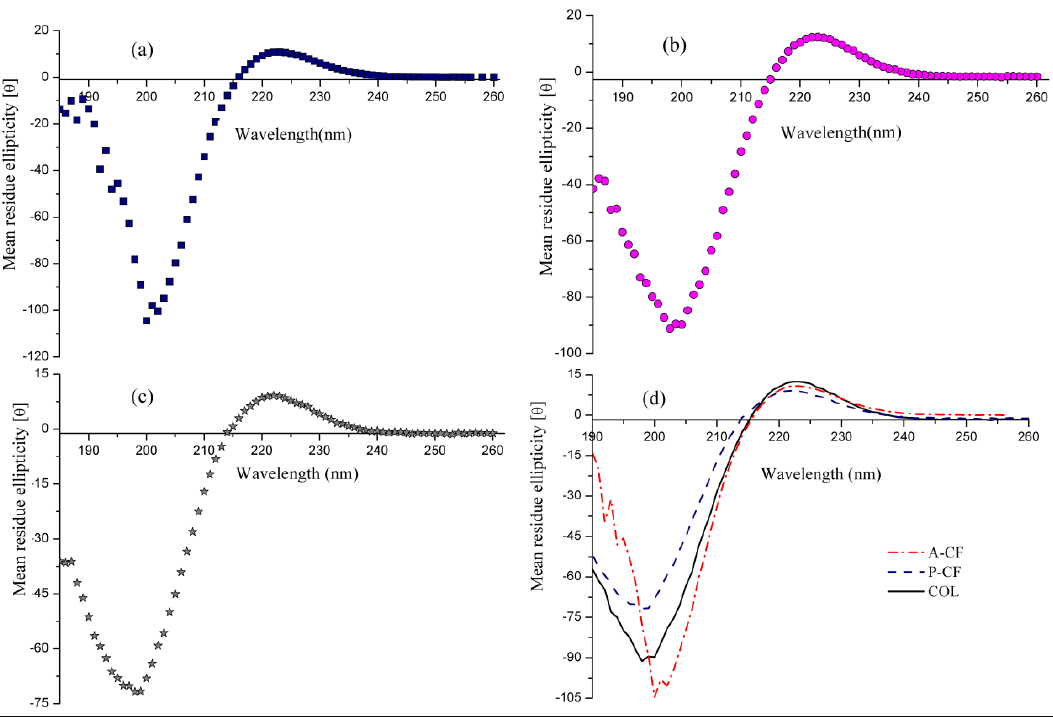
Figure 3. CD spectra of A-CF ( a ), P-CF ( b ) and COL ( c ); and A-CF, P-CF and COL ( d ) in the wavelength range of 185–260 nm at 20 °C.